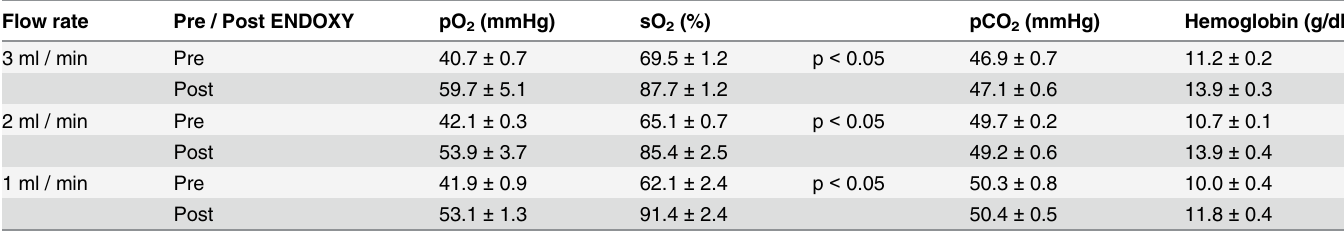
Table 5. Gas transfer measurement of uncoated Lumox ™ slide after redesign — blood gas analysis.